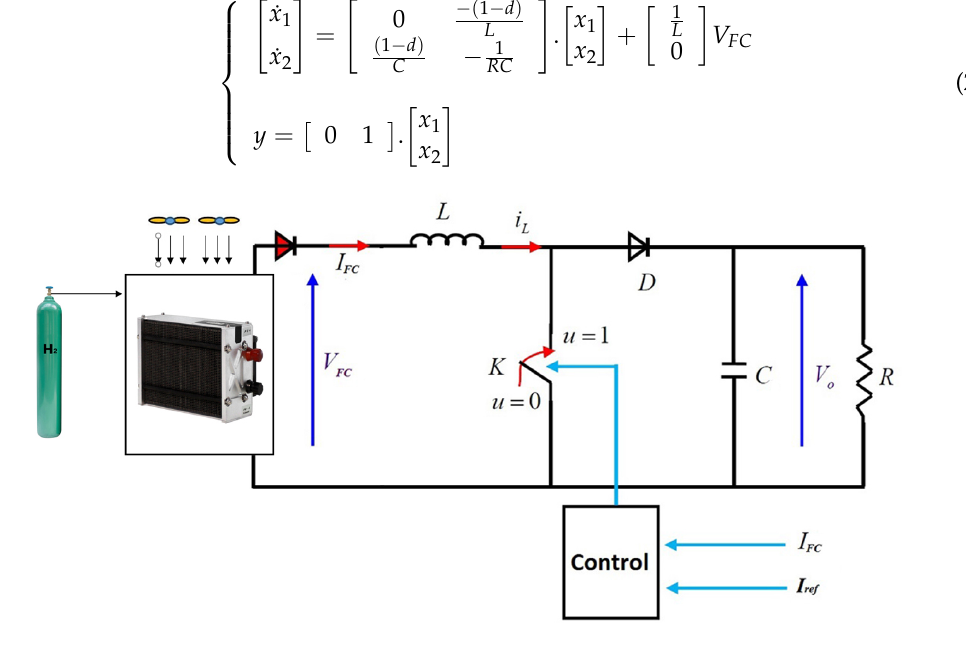
Figure 3. Basic electrical diagram of the boost converter linked to